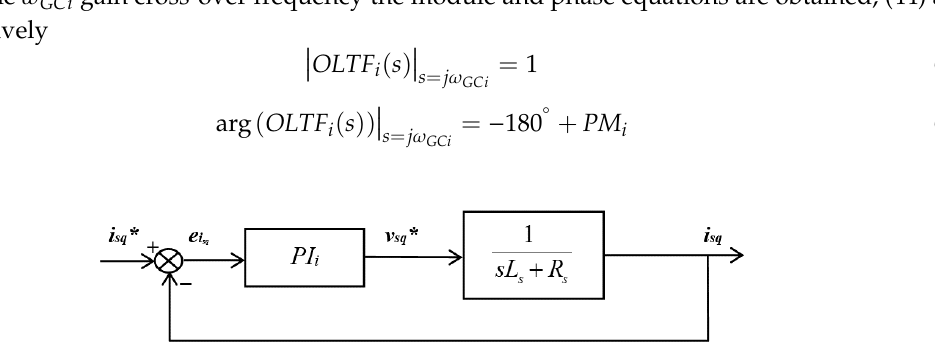
Figure 5. Simplified scheme of the PI regulator for i sq and i sd currents loops (permanent magnet synchronous motor (PMSM) machine case).